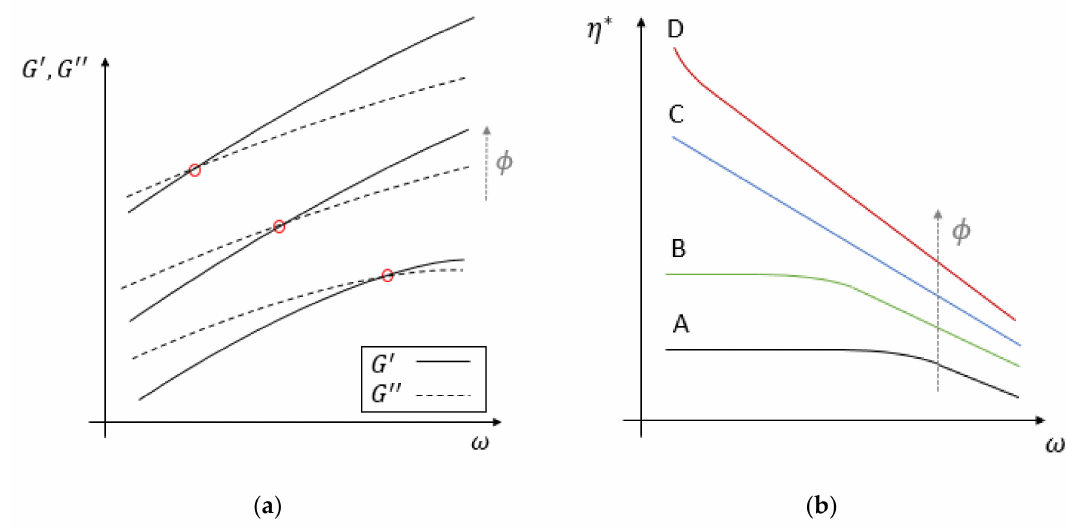
(cid:48)(cid:48) Figure 1. ( a ) Typical dynamic moduli plots ( G (cid:48) solid line, G dashed line) for increasing wood flour content φ . The cross-over points (red dots) shift at lower frequencies as the wood content φ increases; ( b ) Typical complex viscosity plot at increasing wood flour content, showing the Newtonian-like plateau disappearing as the wood content φ increase (curves A, B, and C). Yield may appear at very high wood flour content (curve